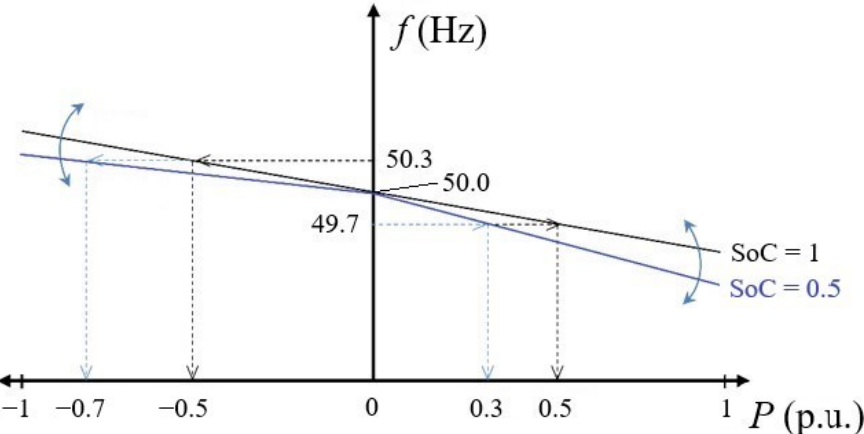
Figure 8. Steady-state characteristic P ( f ) with SoC-dependent droop.